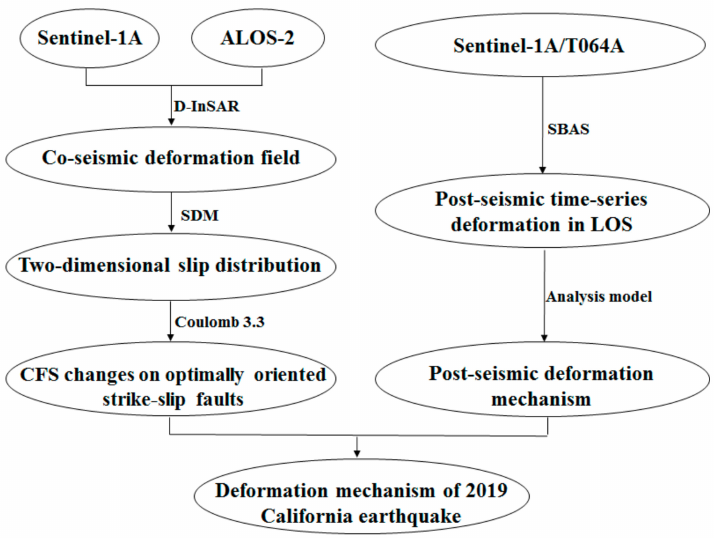
Figure 2. The research process of our manuscript.